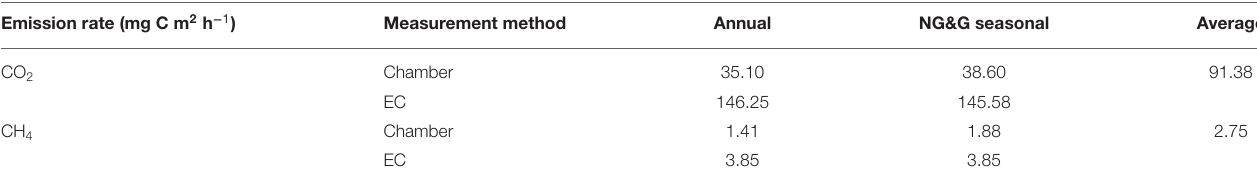
TABLE 1 | Extrapolated mean emission rate of CO 2 and CH 4 of study site for the period 1960–2017, based on models derived from data obtained using the chamber or EC method at different